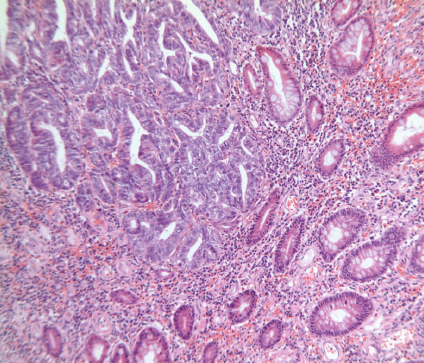
Figure 1: Colon with endometrioid adenocarcinoma (right side) adjacent to endometriosis (left).